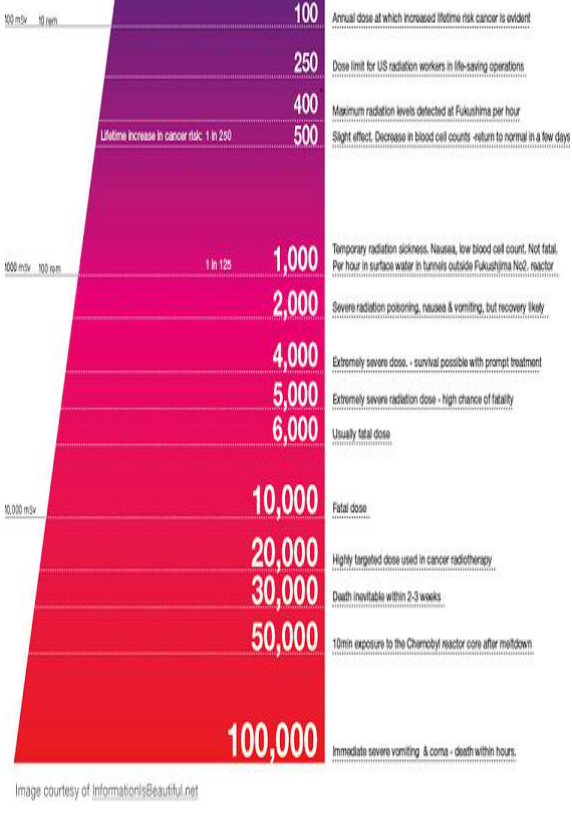
Figure-2 Effect of different doses of radiation